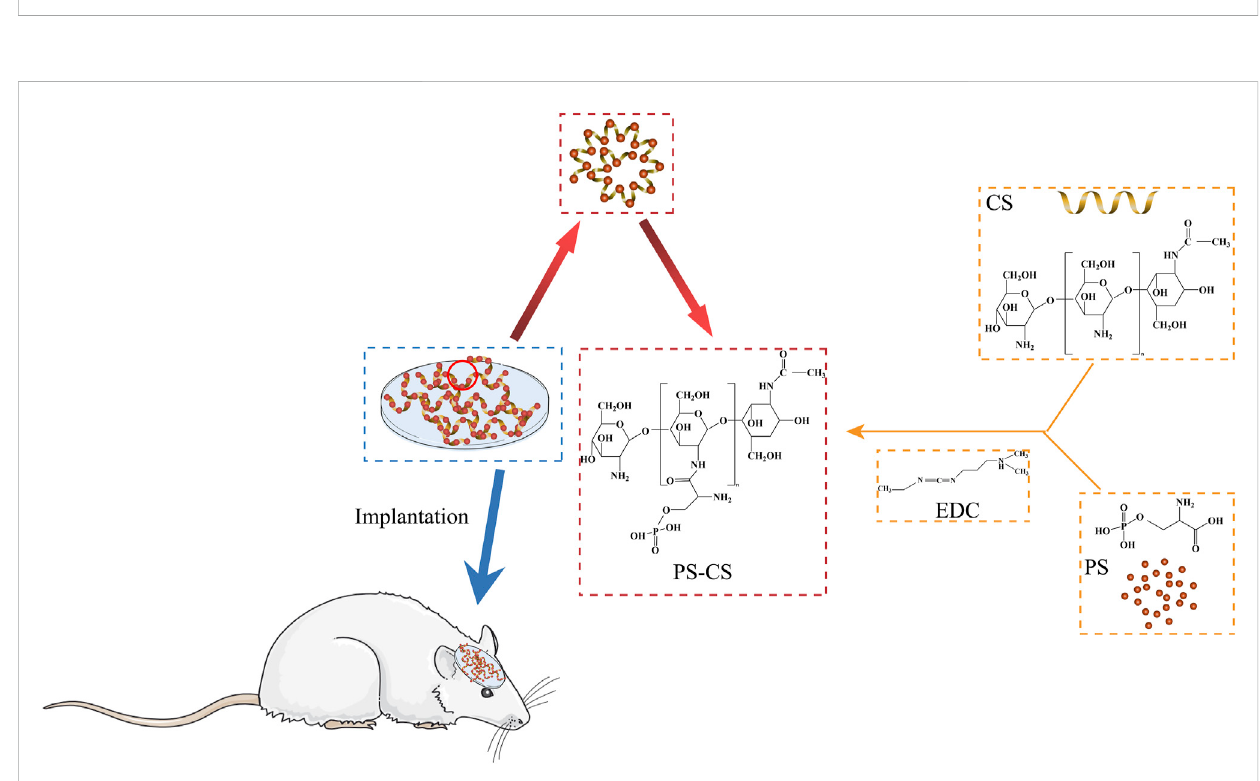
FIGURE 2 Characterizationofmembranes. (A) SEMimagesoffabricatedmembranes. (B) FTIRspectraofthephosphoserinepowder(PS),chitosanmembranes (CS), phosphoserine-chitosan membranes (PS-CS). (C) XRD patterns of the phosphoserine powder (PS), chitosan membranes (CS), phosphoserine- chitosanmembranes(PS-CS). (D) Thedegradationpro fi lesofchitosanmembranes(CS),phosphoserine-chitosanmembranes(PS-CS). (E) EDSelemental mapping for the merged image of all elements. (F) Semi-quantitative determination of elemental composition of these membranes.